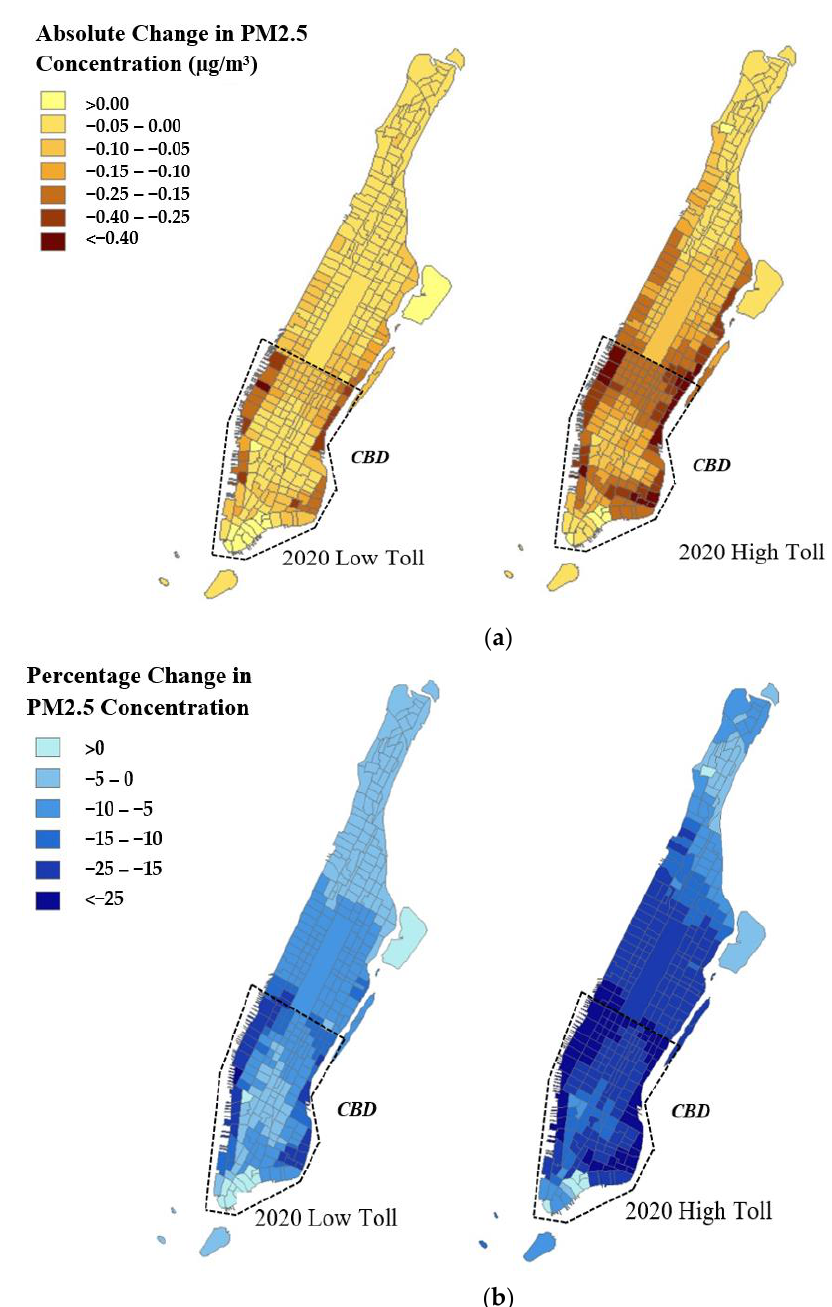
Figure 10. ( a ) Absolute and ( b ) percent change in average daily PM2.5 concentration.